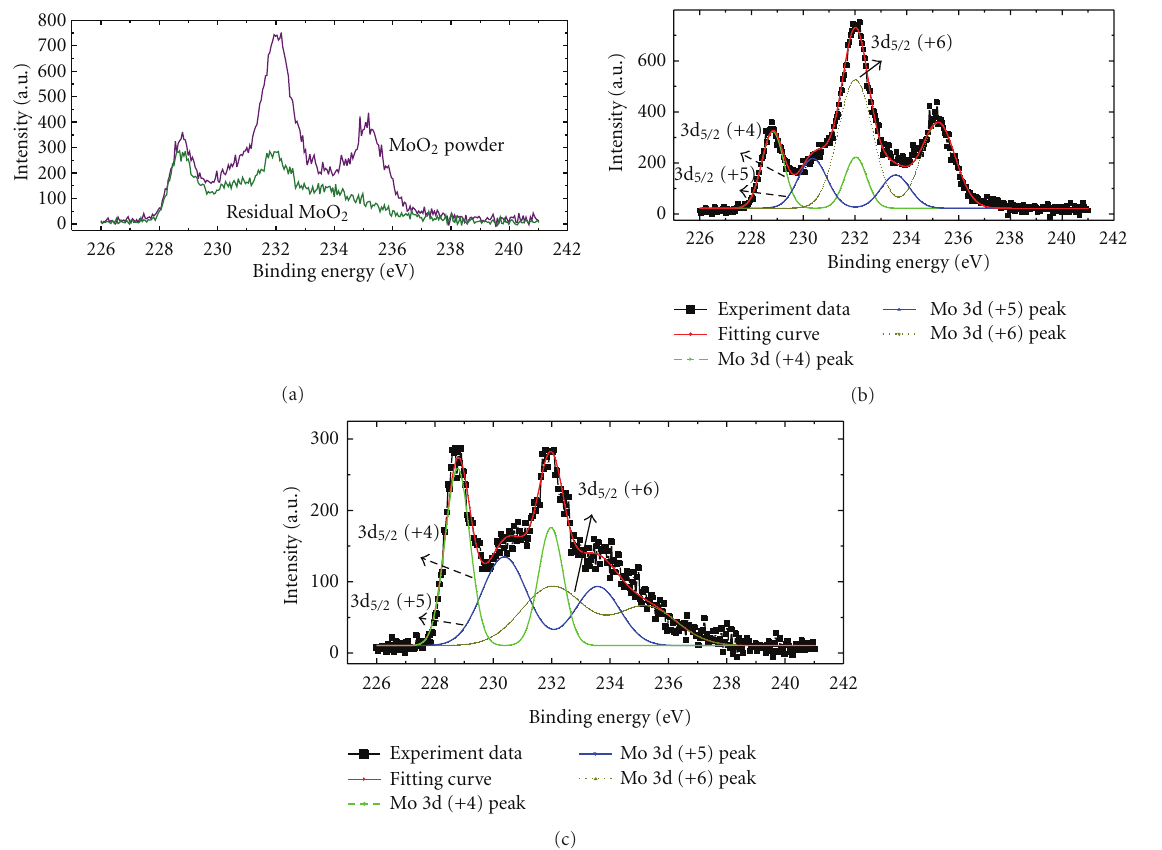
Figure 2: XPS data of molybdenum 3d core level, (a) MoO 2 , powder, and residual MoO 2 powder, (b) peak fitting of Mo 3d spectrum for MoO 2 powder, and (c) peak fitting of Mo 3d spectrum for residual MoO 2